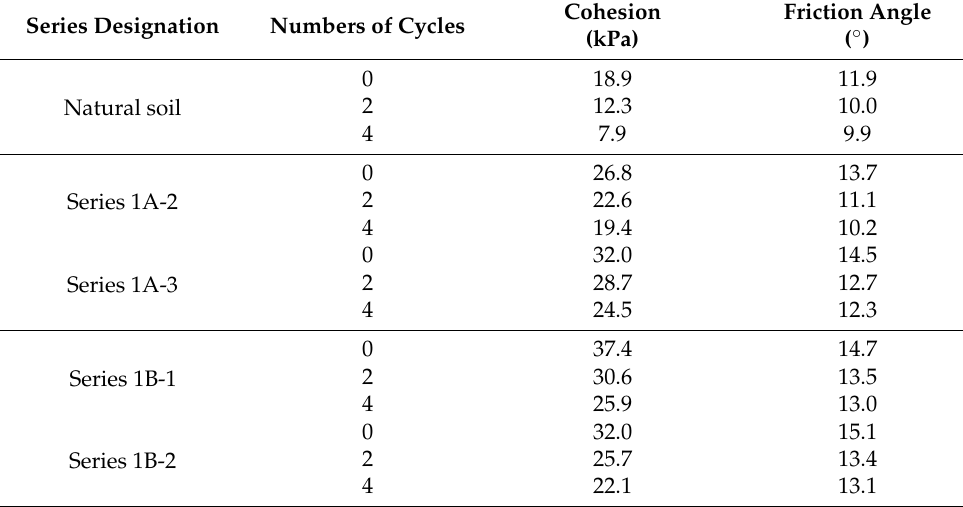
Table 9. Direct shear test results after wetting–drying